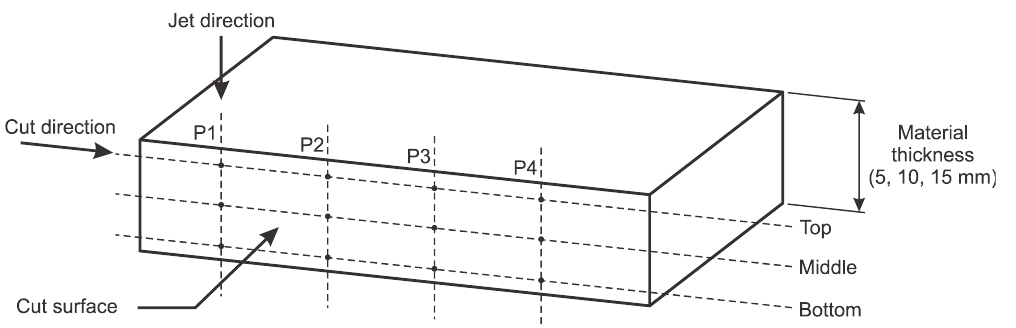
Figure 2. Schematic view of the cut surface with sections and locations where surface roughness was measured.